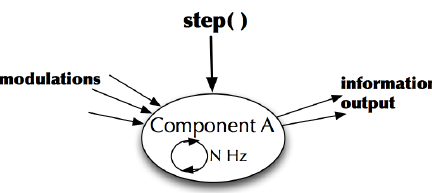
Figure 2. A Behavior-based Iterative Component Architecture (BICA) component.